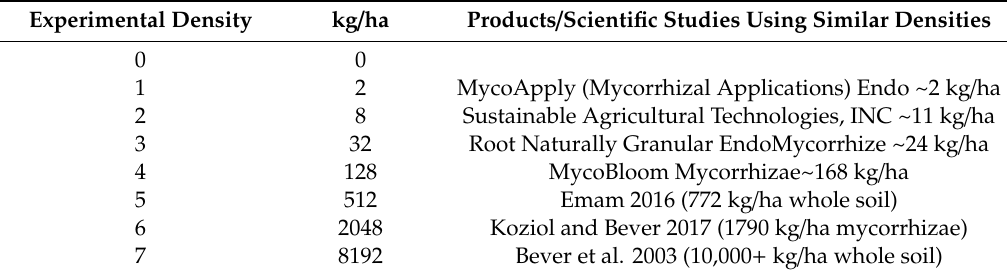
Table 1. Eight di ff erent inoculation densities were chosen for this study. Densities 1–4 represent those recommended by commercial producers of mycorrhizal amendment products. Densities 5–7 represent a few of the inocula application rates used in the scientific